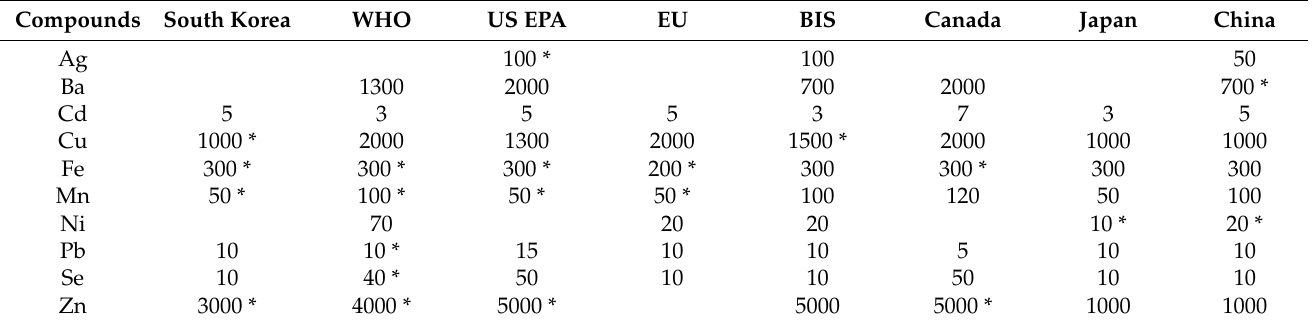
Table 2. Drinking water quality criteria in countries and by organizations ( µ